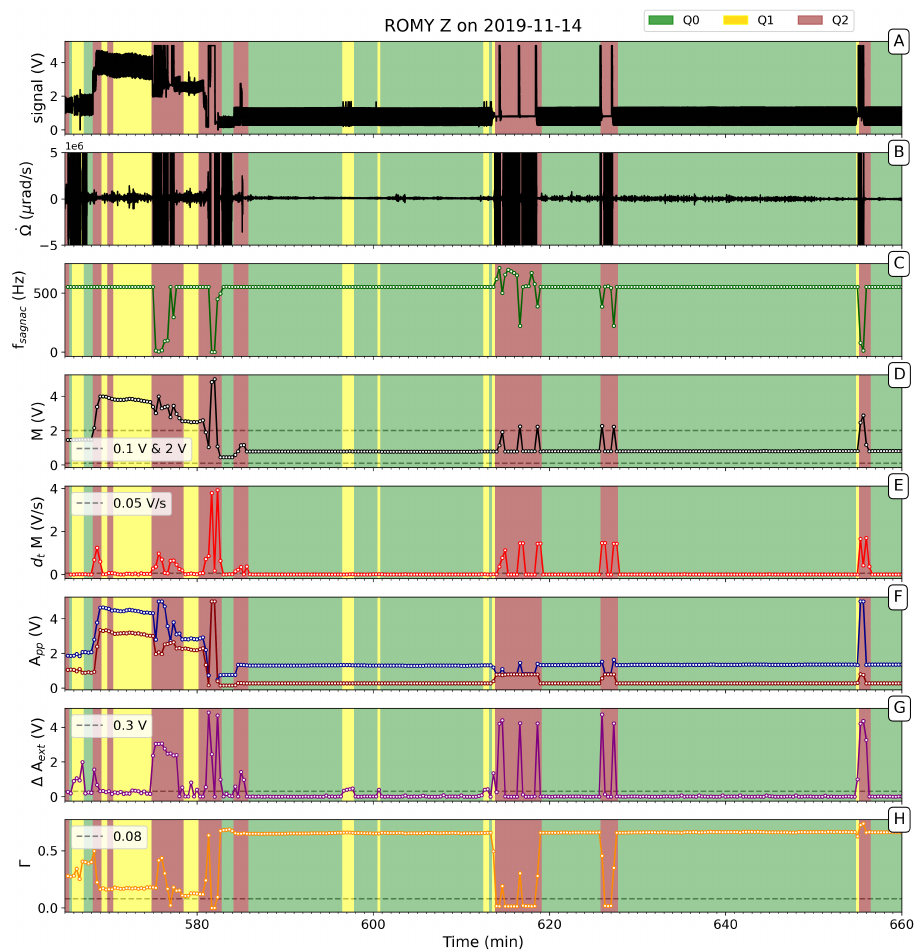
Figure 3. Selected data section of ROMY’s z-component on 2019-11-14. ( A ) Raw beat note signal; ( B ) Obtained rotation rate ˙ Ω (clipped at ± 5 µ rad/s); ( C ) Estimated Sagnac frequency; ( D ) Mean values M ; ( E ) first-order finite-difference of M ; ( F ) Median of maximal and minimal amplitudes A pp ; ( G ) Maximal variance of peak-to-peak amplitudes ∆ A ext ; ( H ) Calculated contrast value Γ . Quality evaluation thresholds are indicated as grey, dashed lines. The background colors correspond to the classified quality